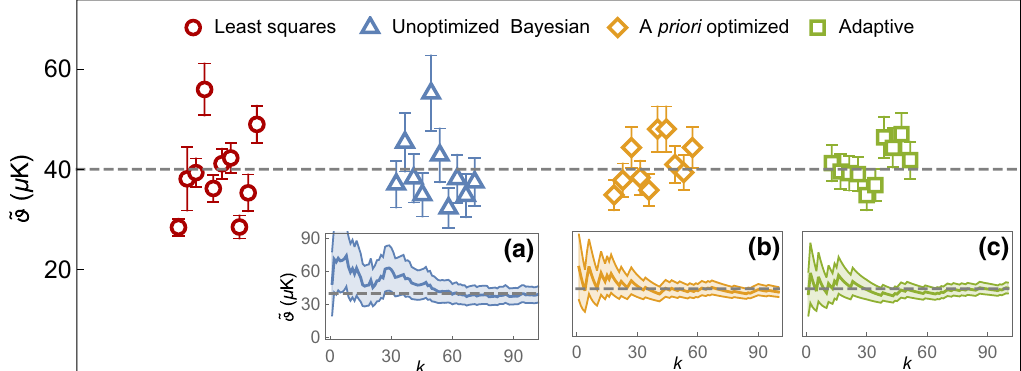
FIG. 1. Reliability of estimation strategies for a trap loaded with a single atom. Temperature estimates and their error bars, obtained from processing simulated release-recapture measurements on a single 41 K atom with different protocols (see Sec. II D for details). The results obtained from ten different realizations are shown. The underlying true temperature is set to 40 μ K (dashed gray). First, a record with 30 measurements at seven unoptimized expansion times is fitted to the recapture probability, as discussed in Sec. II B (red circles), as well as processed with our Bayesian-global technique (blue triangles). The time-optimized methods are also applied to the same overall number of data points (i.e., 210), respectively simulated at the optimal a priori recapture time t s (orange rhombs) and at adaptively chosen variable optimal times (green squares). Optimization of the recapture times noticeably reduces the variability of the estimates. Note that there is no abscissa axis in the main plot; the estimates have been squeezed together to help visualize their variability. Insets (a)–(c) show the typical convergence of global estimates with the number of measurements k . As shown, time- optimized methods typically require much less data to converge, when compared with their unoptimized counterparts. Also, the final error bars are smaller in (b) and